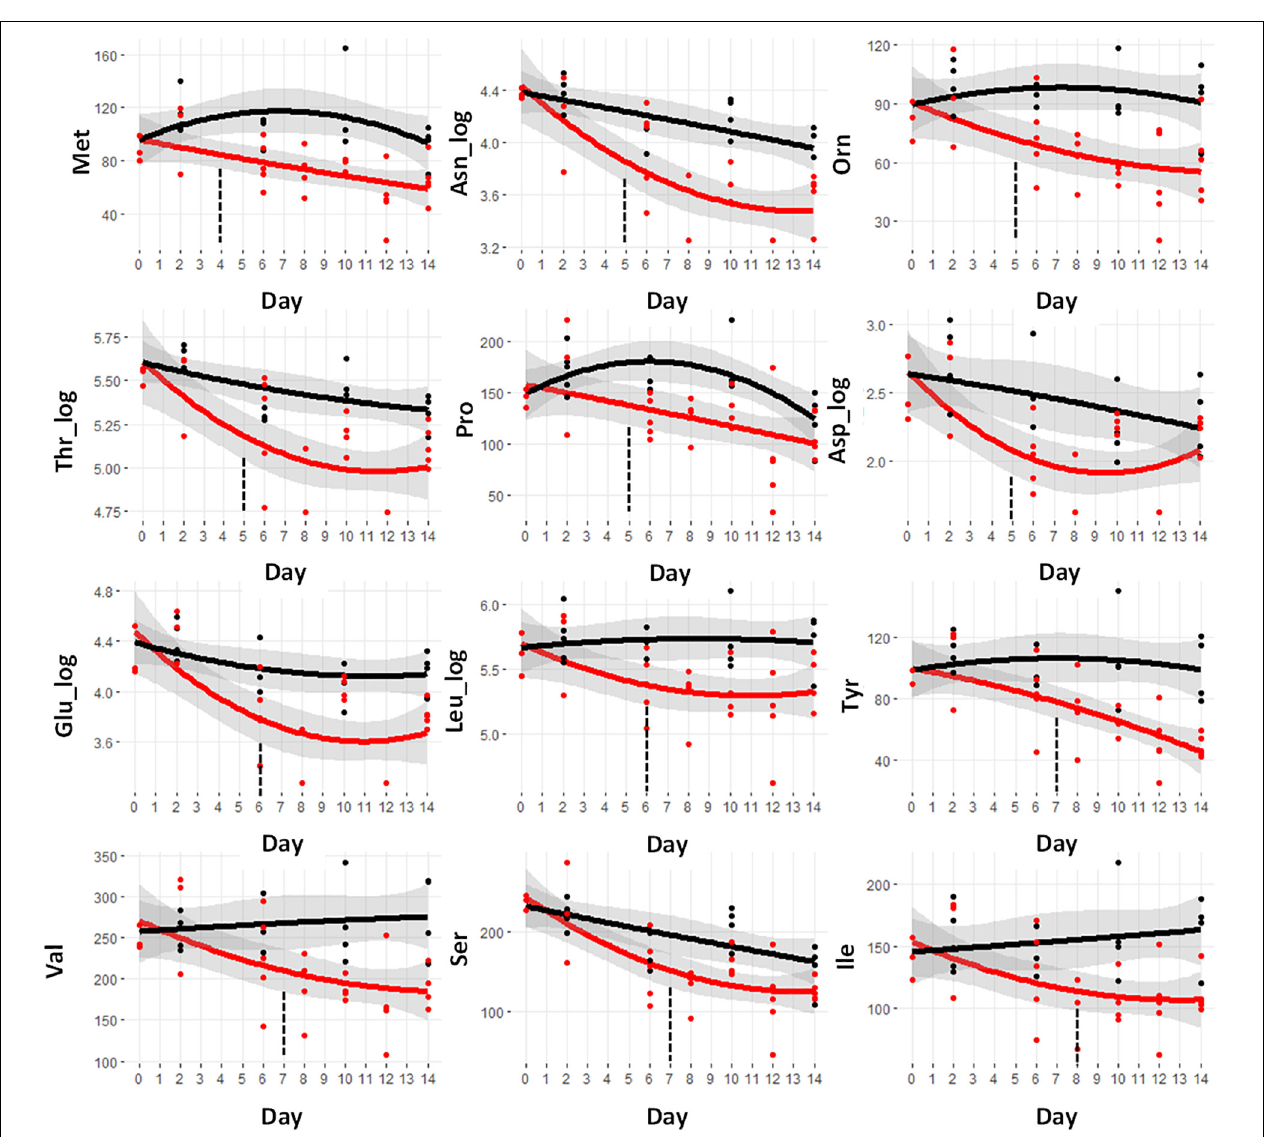
FIGURE 3 | Trajectory of amino acid concentrations that were statistically significantly different prior to the observation of significant weight loss at day 9. Black indicates control mice, red indicates cachectic mice, and the vertical dashed lines indicate the day in which the data were first significantly